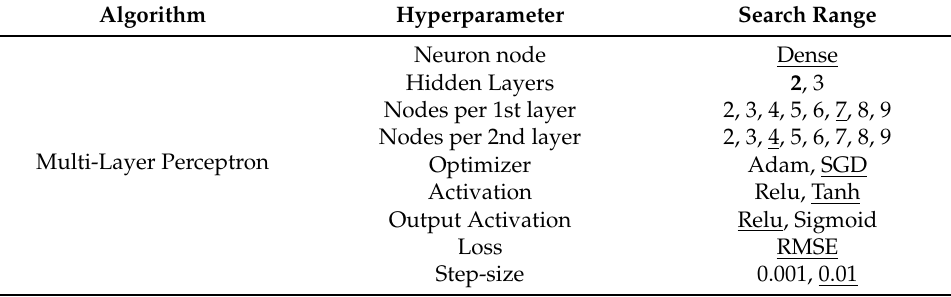
Table 4. Remaining useful life hyperparameter